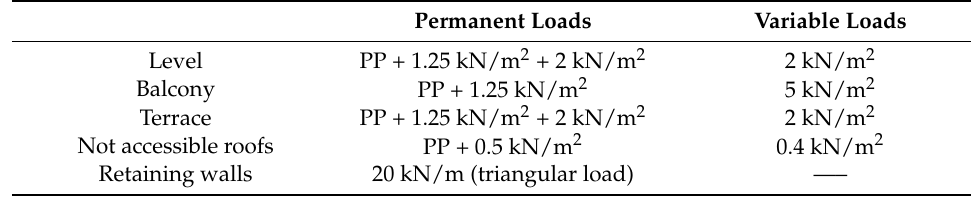
Table 1. Values of the applied loads and load combinations.